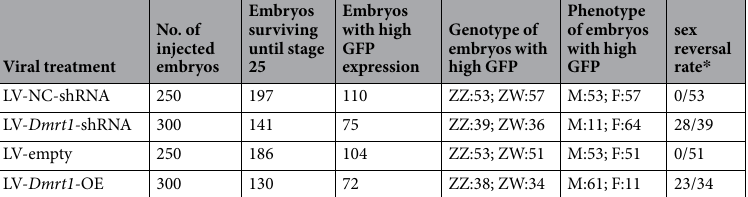
Table 1. Phenotypes of embryos with knockdown or over-expression of Dmrt1 . Genotype of embryos with high GFP was determined by karyotype analysis and qPCR of 18S rRNA gene. Phenotype of embryos was assessed by gonadal histology, immunofluorescent marker expression or qRT-PCR. * Male to female sex reversal rate = No. of feminized genetic male embryos/total No. of ZZ embryos; female to male sex reversal rate = No. of masculinized genetic female embryos/total No. of ZW embryos.